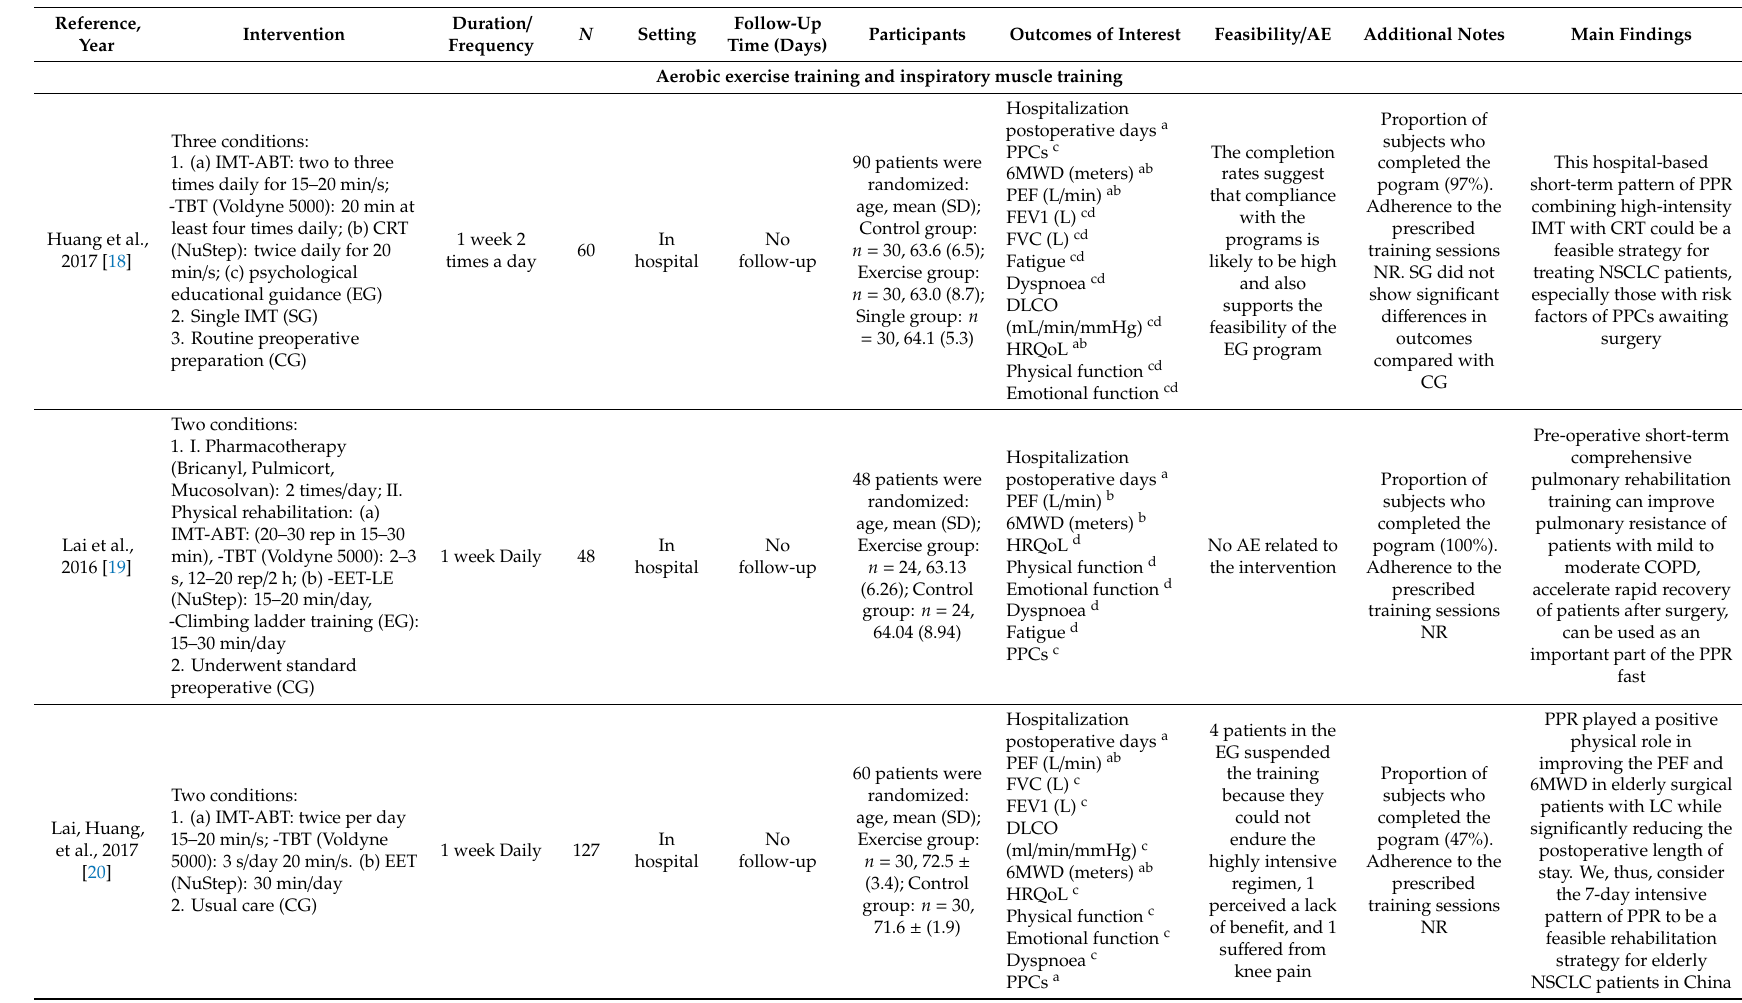
Table 1. Characteristics of included